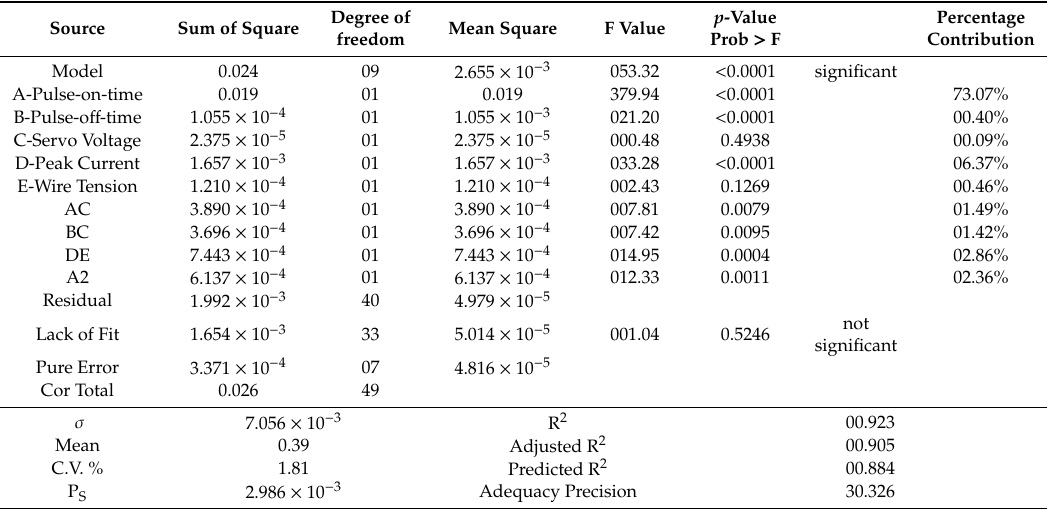
Table 5. Results of ANOVA analysis for the kerf width (K f